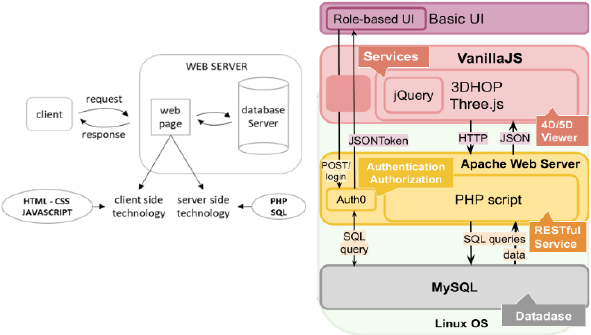
Figure 2. System architecture of METEORA platform. Left: Client-side to server-side communication. Right: Technological tools and interactions of the 3-Tier Architecture model.